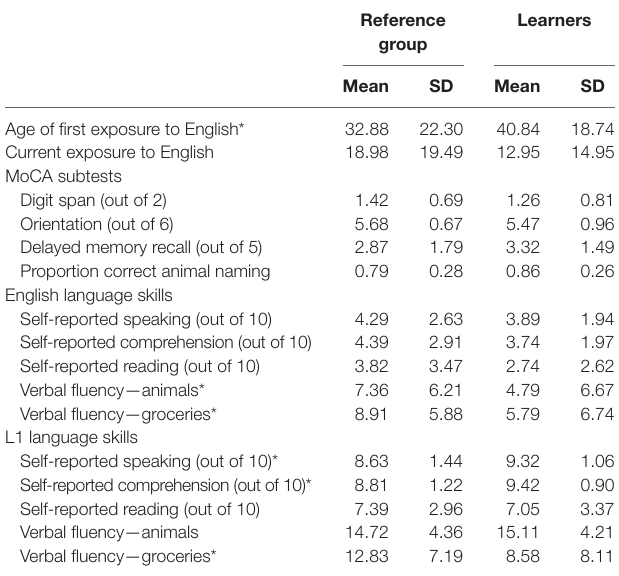
Table 1 | Participant characteristics of the reference group ( n = 53) and the learner subset ( n =